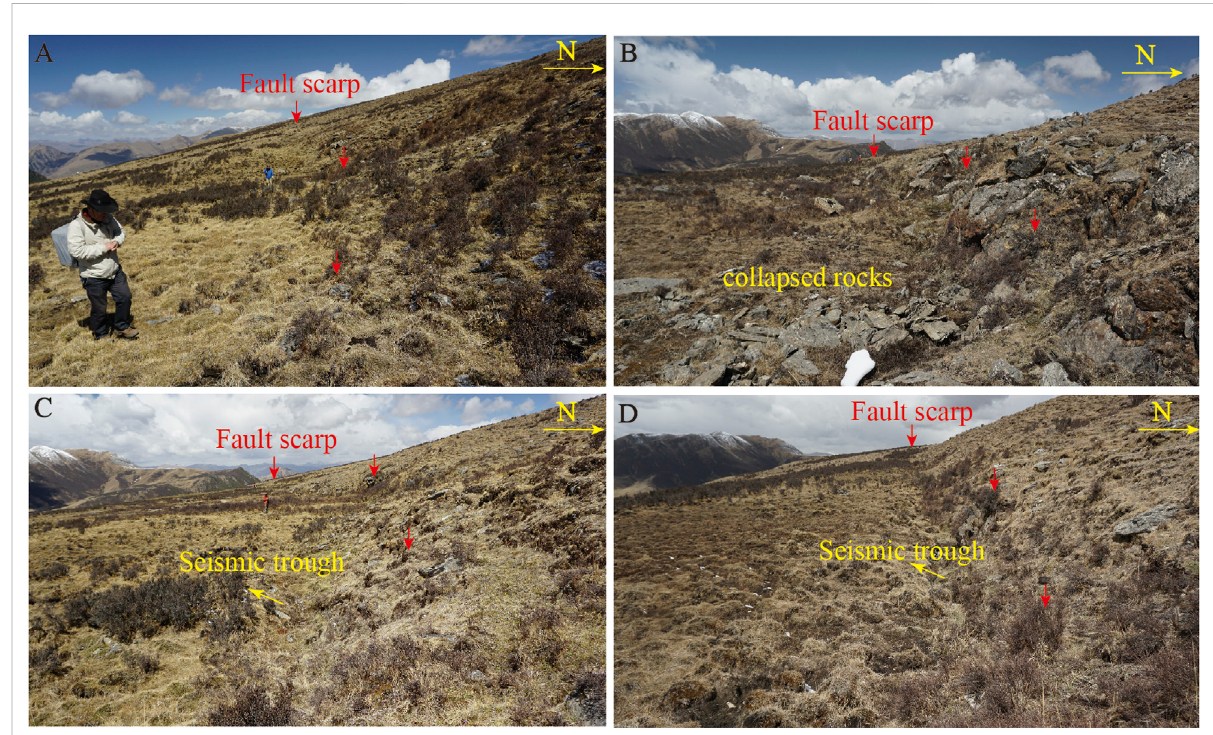
FIGURE 9 Seismic surface rupture track near Dongjiuma, close to Babang. (A) Seismic scarp (E98.74541 ° , N31.68088 ° ), (B) seismic scarp and collapsed rocksunderthescarpas aresultofanearthquake(E98.74636 ° ,N31.68085 ° ),and (C) and (D) seismictroughsdevelopedunderthescarpasaresultof an earthquake (coordinates E98.74887 ° , N31.6807 ° and E98.75156 ° , N31.67963 ° , respectively).